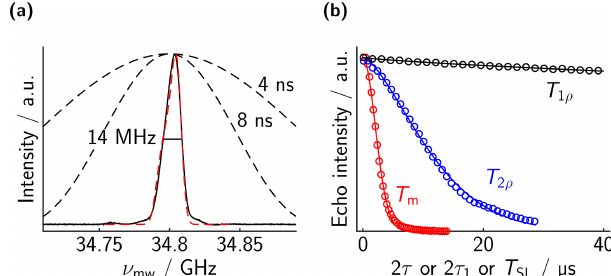
Figure 3. Measurements on mono-trityl 7 . (a) EPR spectrum. The excitation profiles of the rectangular pulses used are indicated. They are sufficiently strong to excite the whole EPR line. The red dashed lines indicate a simulation based on the g values given in Hintz et al. (2019) and a Gaussian broadening of 8MHz FWHM. (b) Cor- responding echo decay curves. Experimental points in circles (not all points shown for clarity) and best fit in solid lines. The fit- ted values are T m = 2 . 9µs ( ξ = 5 . 9), T 2 ρ = 13 . 1µs ( ξ = 4 . 6), and T 1 ρ = 930µs ( ξ = 2 . 4).